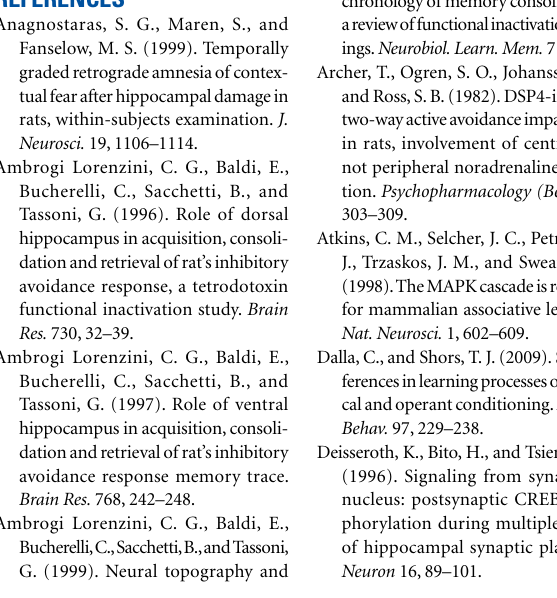
FIGURE 9 | Two-way active avoidance (TAA). (A) Percent avoidance response (% ARs) over 3 days (30 trials/day) is plotted. Repeated measures ANOVA revealed no signifi cant main effect of genotype ( F